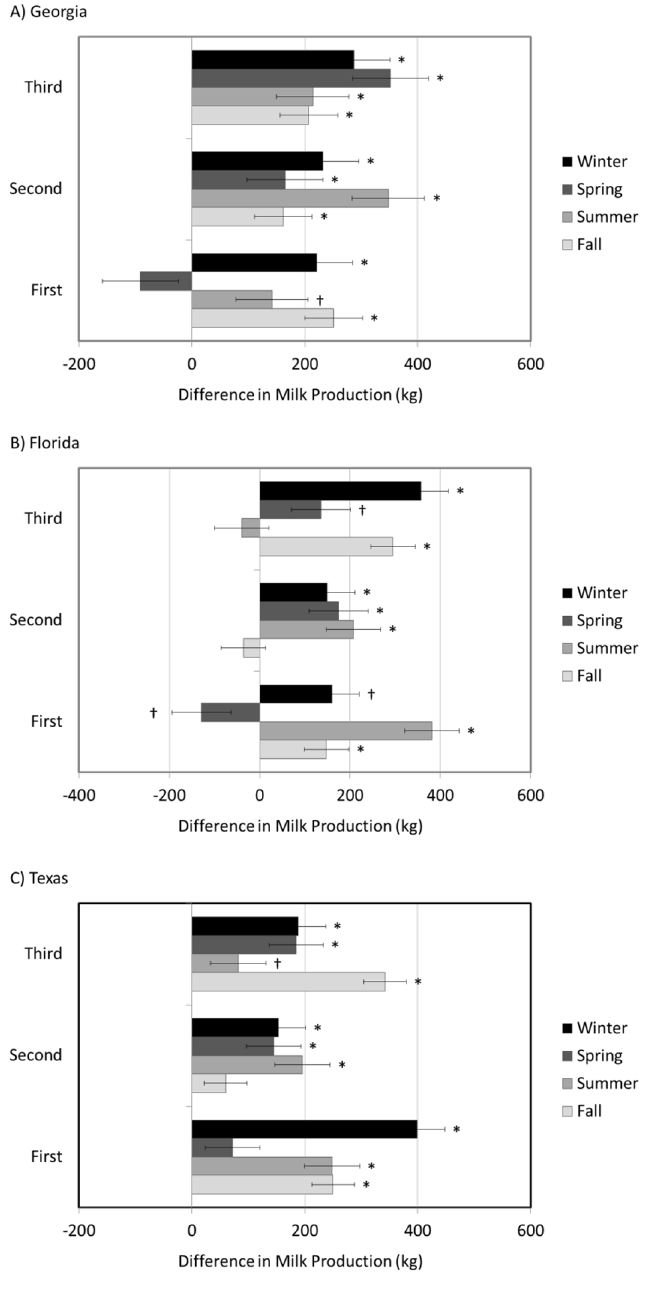
Fig 2. Differences in mature-equivalent milk yield (kg) between thermoneutral conceived (TNC) and heat stress conceived (HSC) cows in Georgia (A), Florida (B) and Texas (C) during their first, second and third lactations. In instances where TNC cows produced more milk than their HSC counterparts, those values are positive. In instances where HSC cows produced more milk than their TNC counterparts, those values are negative. Bars with * denotes a significant difference (P < 0.01) while † denotes a tendency for a difference (P <